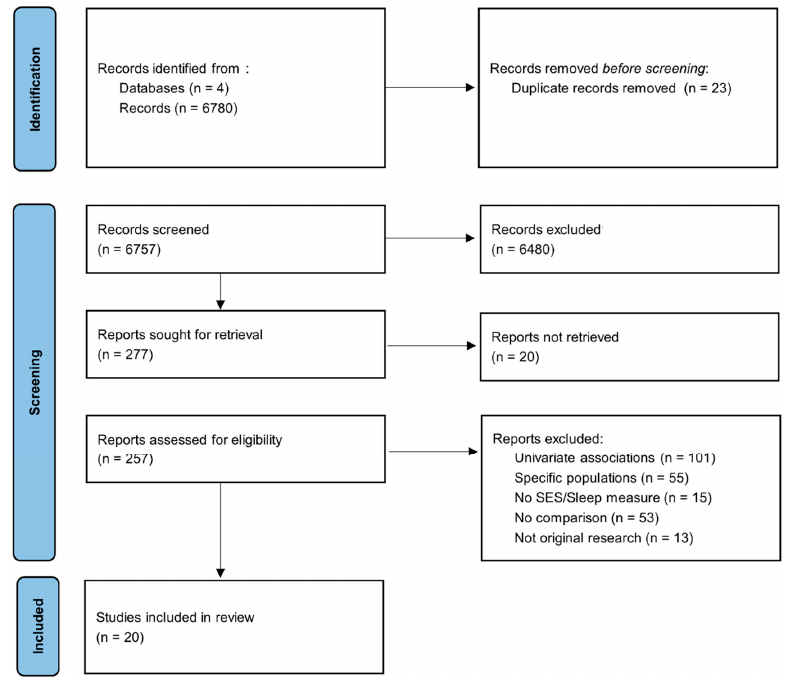
Figure 1. Prisma flowchart of study selection process: the relationship between EDS and SEP.